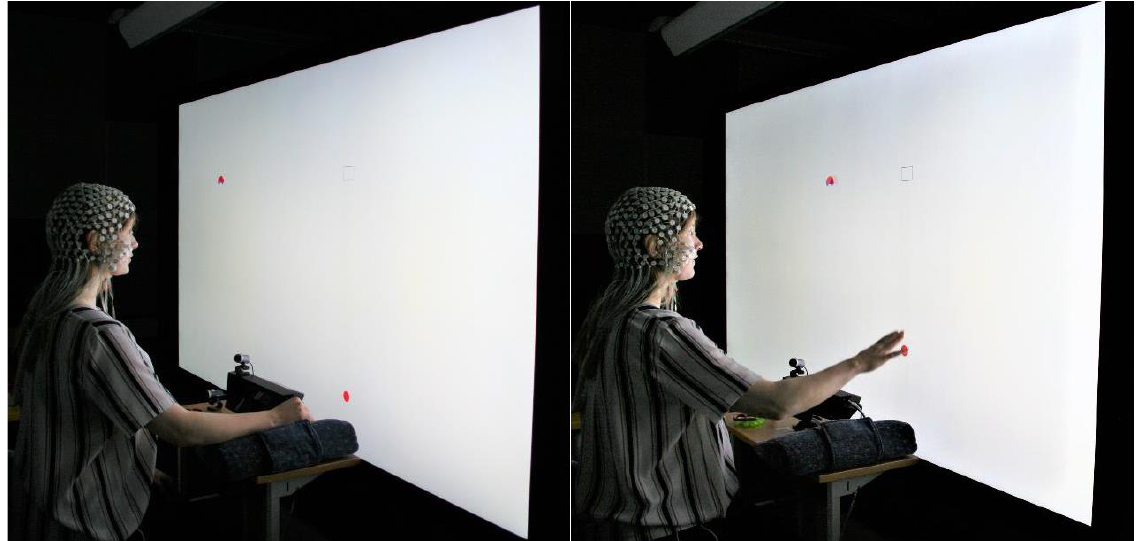
Figure 4. Experimental set up and procedure. While wearing a 256-channel Geodesic Sensor Net, participants sat in front of a large Microsoft SurfaceHub 1.0 4k touchscreen and were asked to move a red dot upwards with the index finger of their right dominant hand to the designated catching location to intercept a horizontally moving car that approached under three different accelerations.